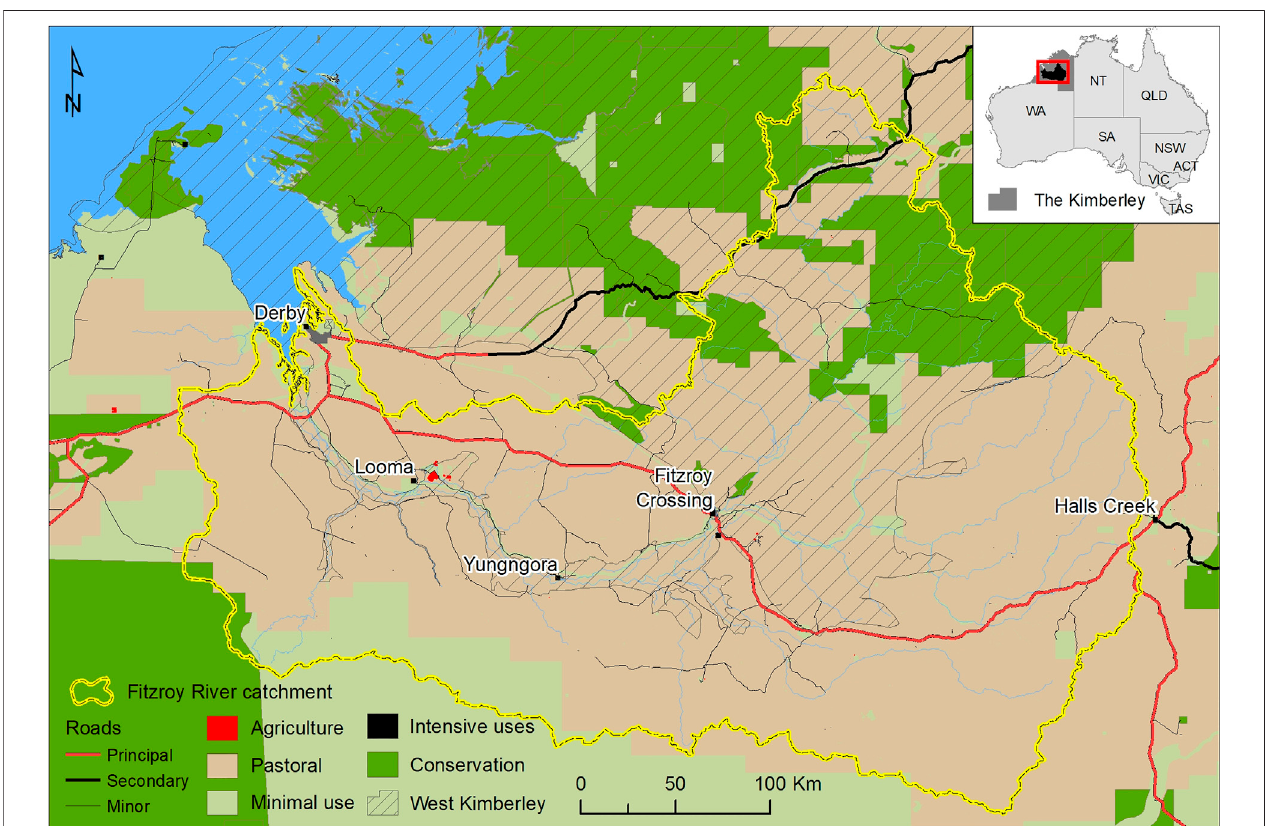
FIGURE 3 | Case study area. Location of the Martuwarra (Fitzroy River) catchment in the Kimberley region of north Western Australia (WA); the map shows major land uses, conservation areas and boundaries of the West Kimberley Heritage Place. Data sources: Catchment Scale Land Use Mapping for Western Australia 2018; Collaborative Australian Protected Areas Database 2018; Geoscience Australia (2006) GEODATA TOPO 250K Series